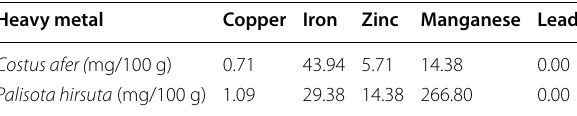
Table 8 Heavy metal analysis of Costus afer and Palisota hirsuta Heavy